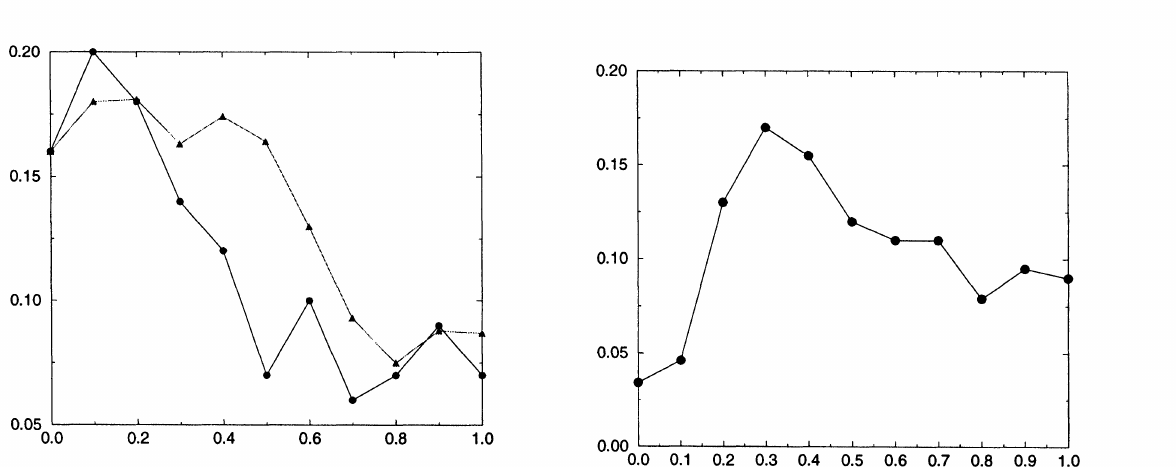
FIGURE 6 Amplitude of the main peak of the power spec- trum as a function of PI. The maximum around PI 0.1 indi- cates the situation of optimal coordination of the collective movement.